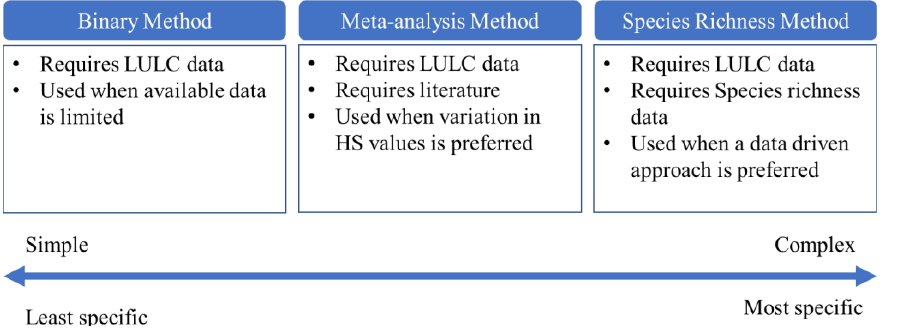
Figure 8. A comparison of the three methods. Method selection depends on the available data, complexity level, and research goals.